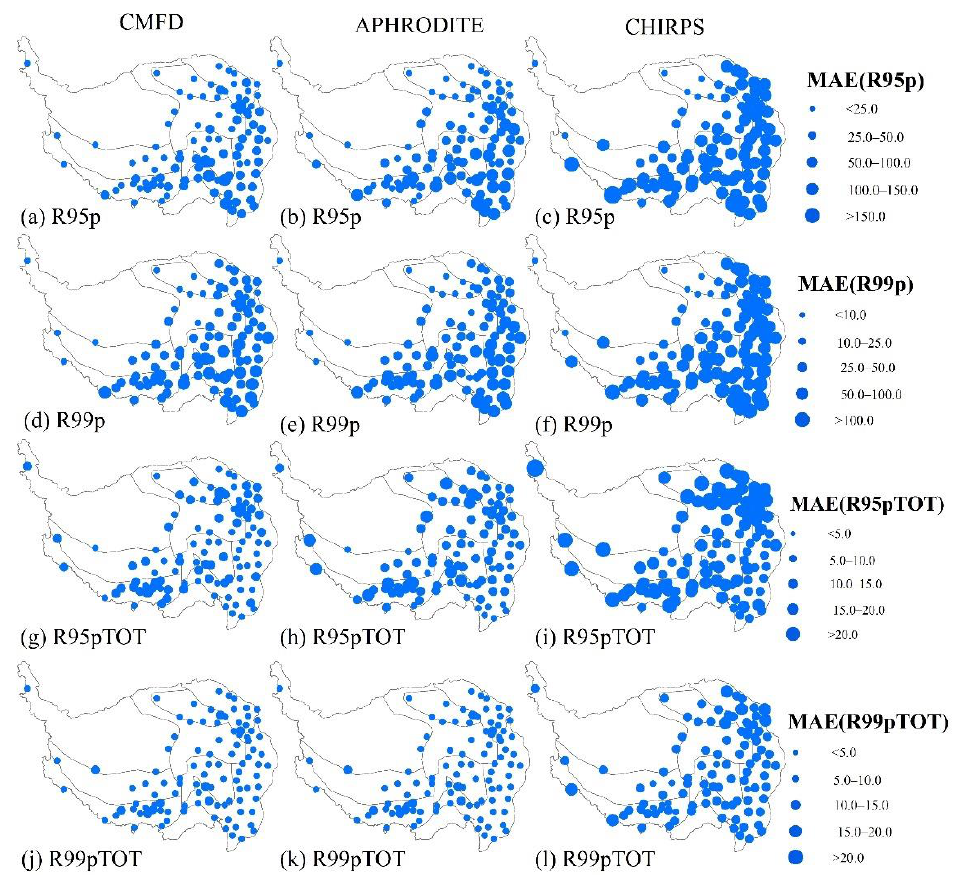
Figure 13. MAE for gauge-based station threshold indices R95p, R99p, R95pTOT, and R99pTOT as derived from CMFD, APHRODITE, and CHIRPS for the period 1981 – 2014.